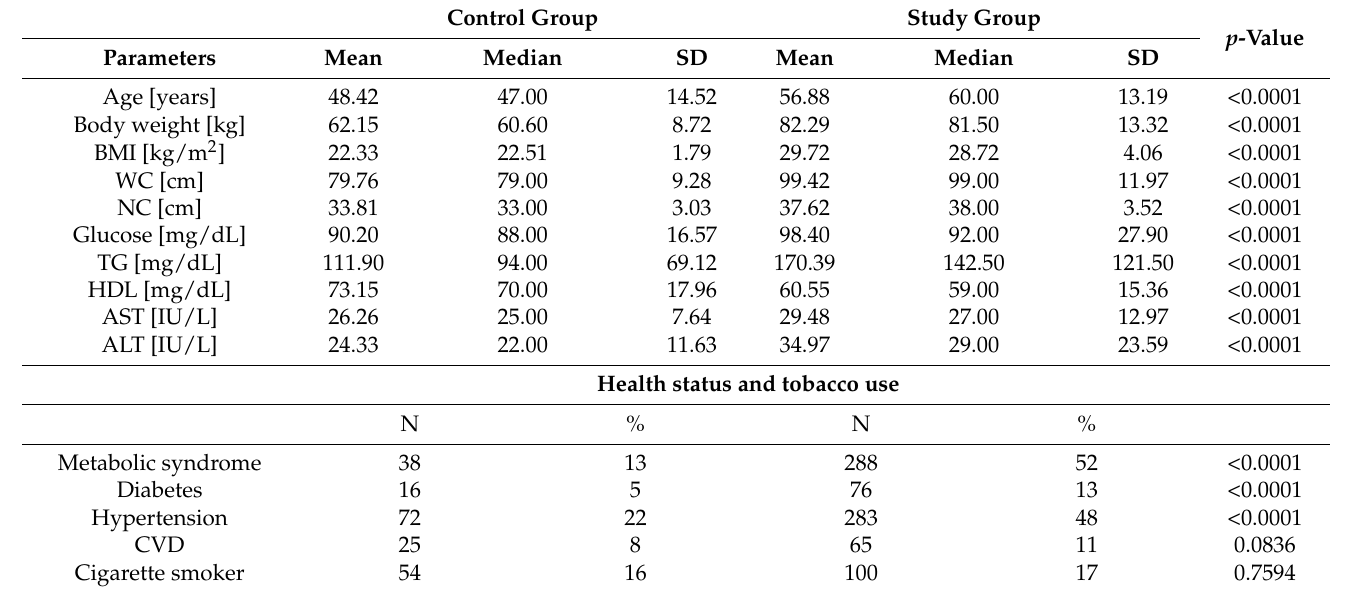
Table 1. The detailed characterization of the control and the study group. Control Group Study Group